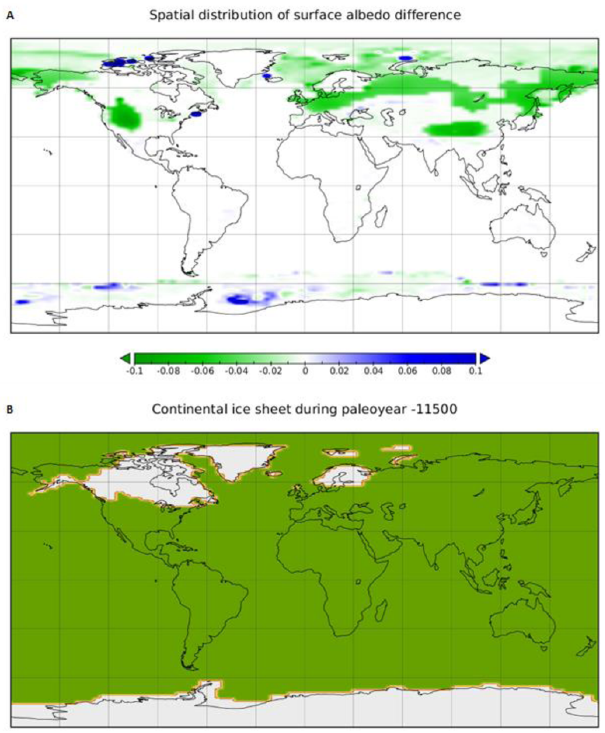
Fig. 2. Spatial distribution of (a) difference in surface albedo (EXT- CTL) averaged over the 500th year of the climate model simulation and (b) prescribed ice sheets during the 500th